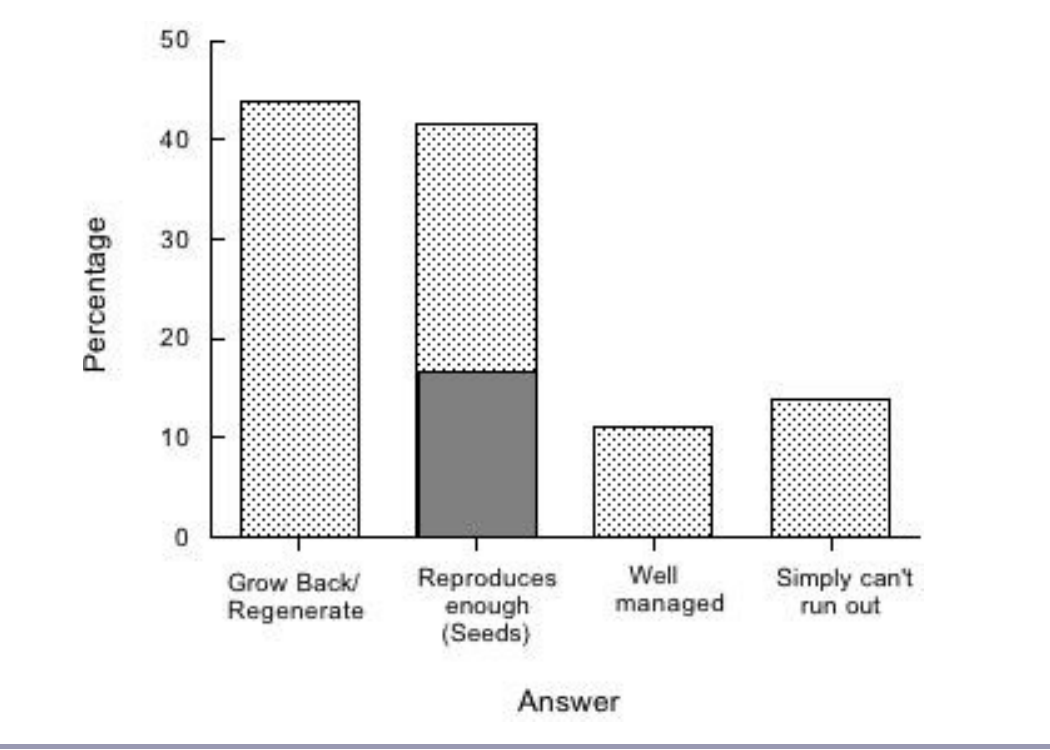
Fig. 3. Responses from the semidirected interviews of the 36 subjects who viewed mangroves as an inexhaustible resource when asked to specify why. The values exceed 100% because many subjects gave more than one explanation in their responses. The dark shading on the “Reproduces enough” column indicates people who specifically said that mangroves produce many